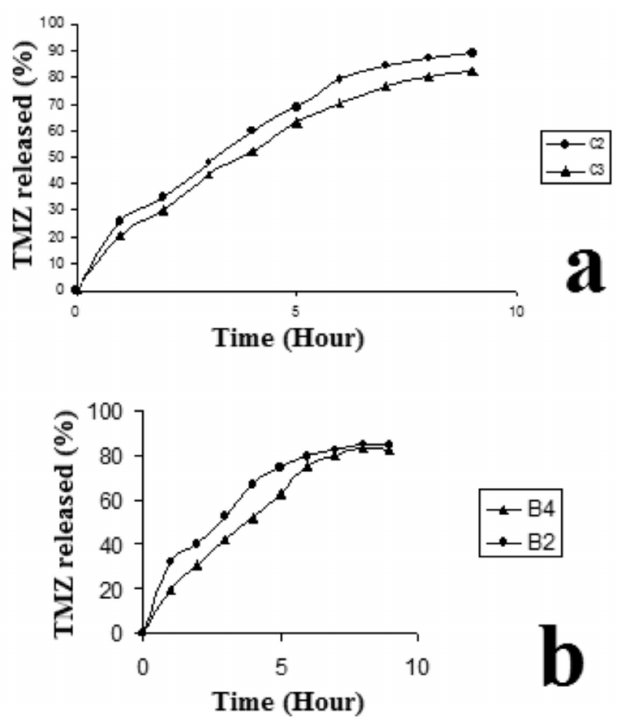
FIGURE 4 - Effect of sodium alginate concentration on TMZ release from calcium alginate beads (a) Sequential method (b) Simultaneous method. (Maximum SEM ±3.70%, n=